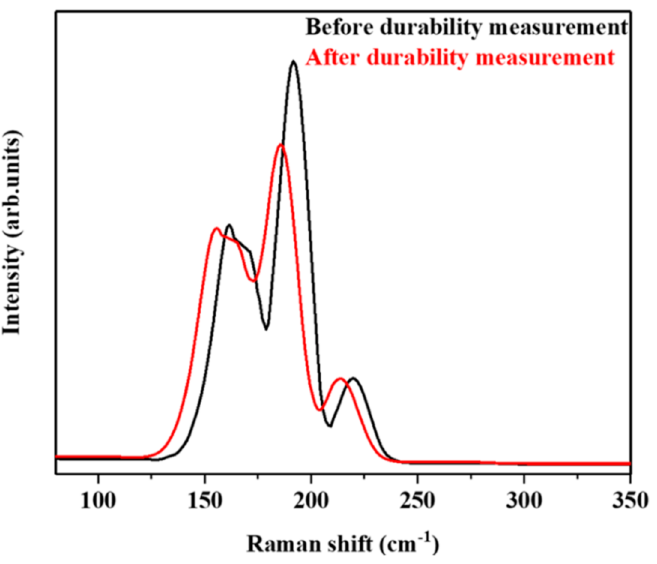
Figure 7. Raman measurements of the S3 nanosheet films before and after a 40-min-long durabil- ity